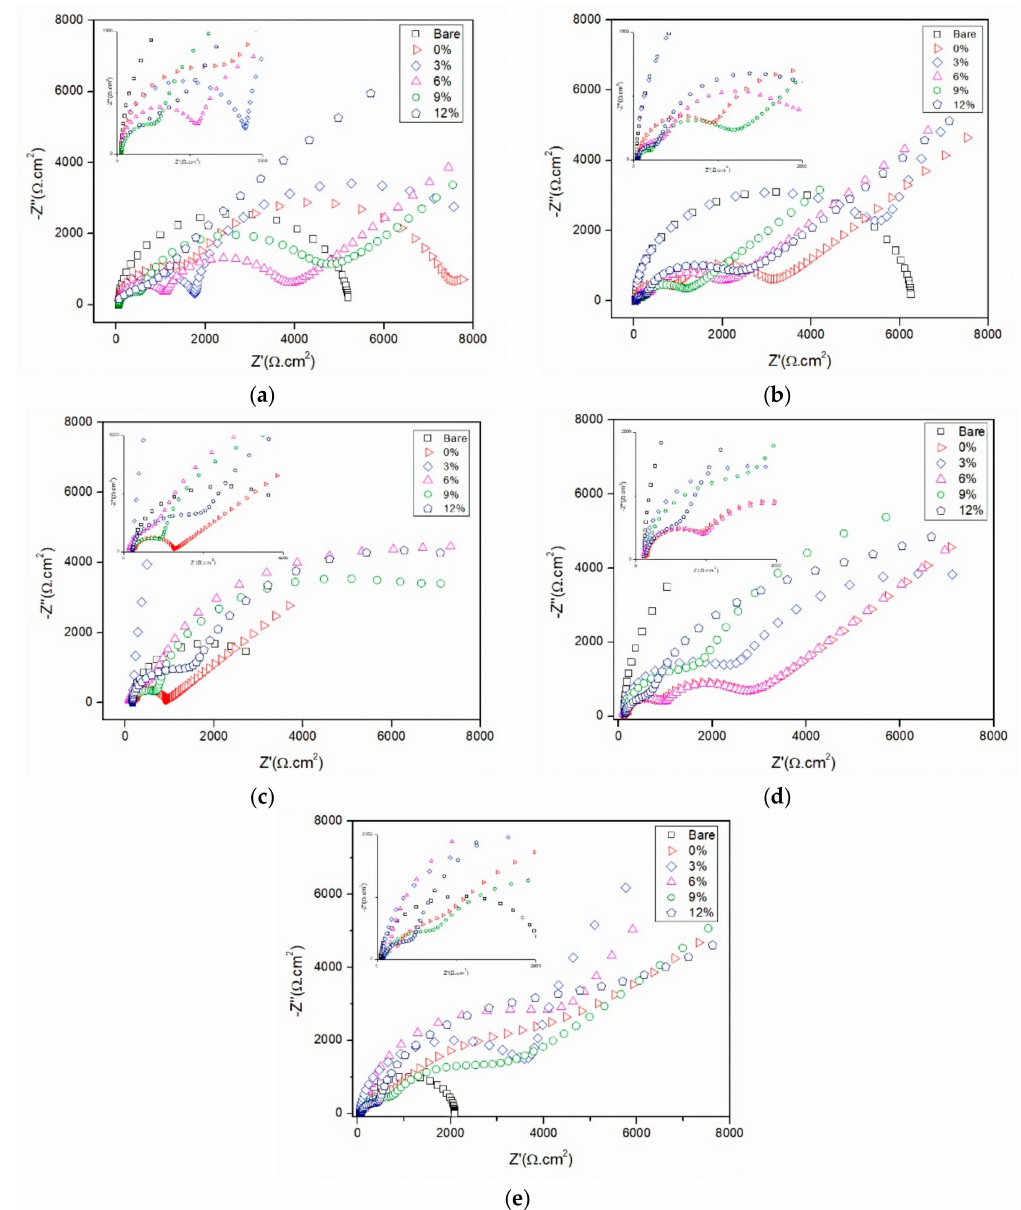
Figure 13. Nyquist plots of the coated and uncoated SS316L at ( a ) 10, ( b ) 20, ( c ) 30, ( d ) 40 and ( e ) 50 days of the immersion test at Setiu, Terengganu,